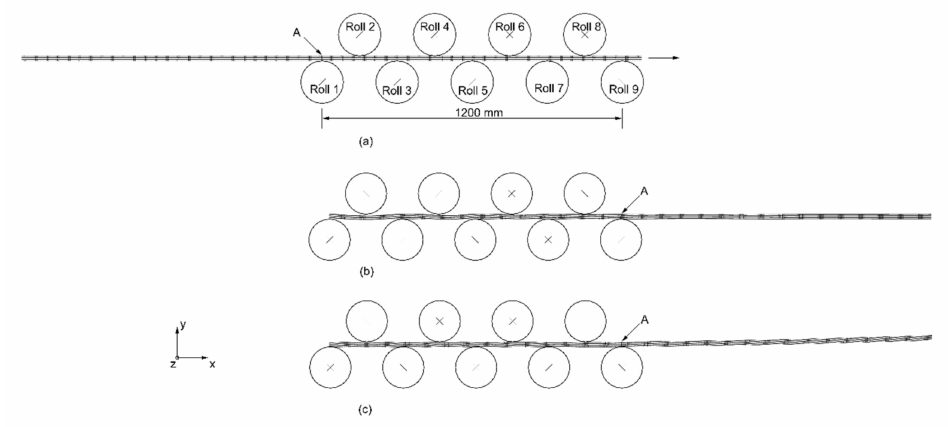
Figure 12. ( a ) The initial configuration, ( b ) a deformed configuration before spring-back, and ( c ) a deformed configuration after spring-back of the finite element